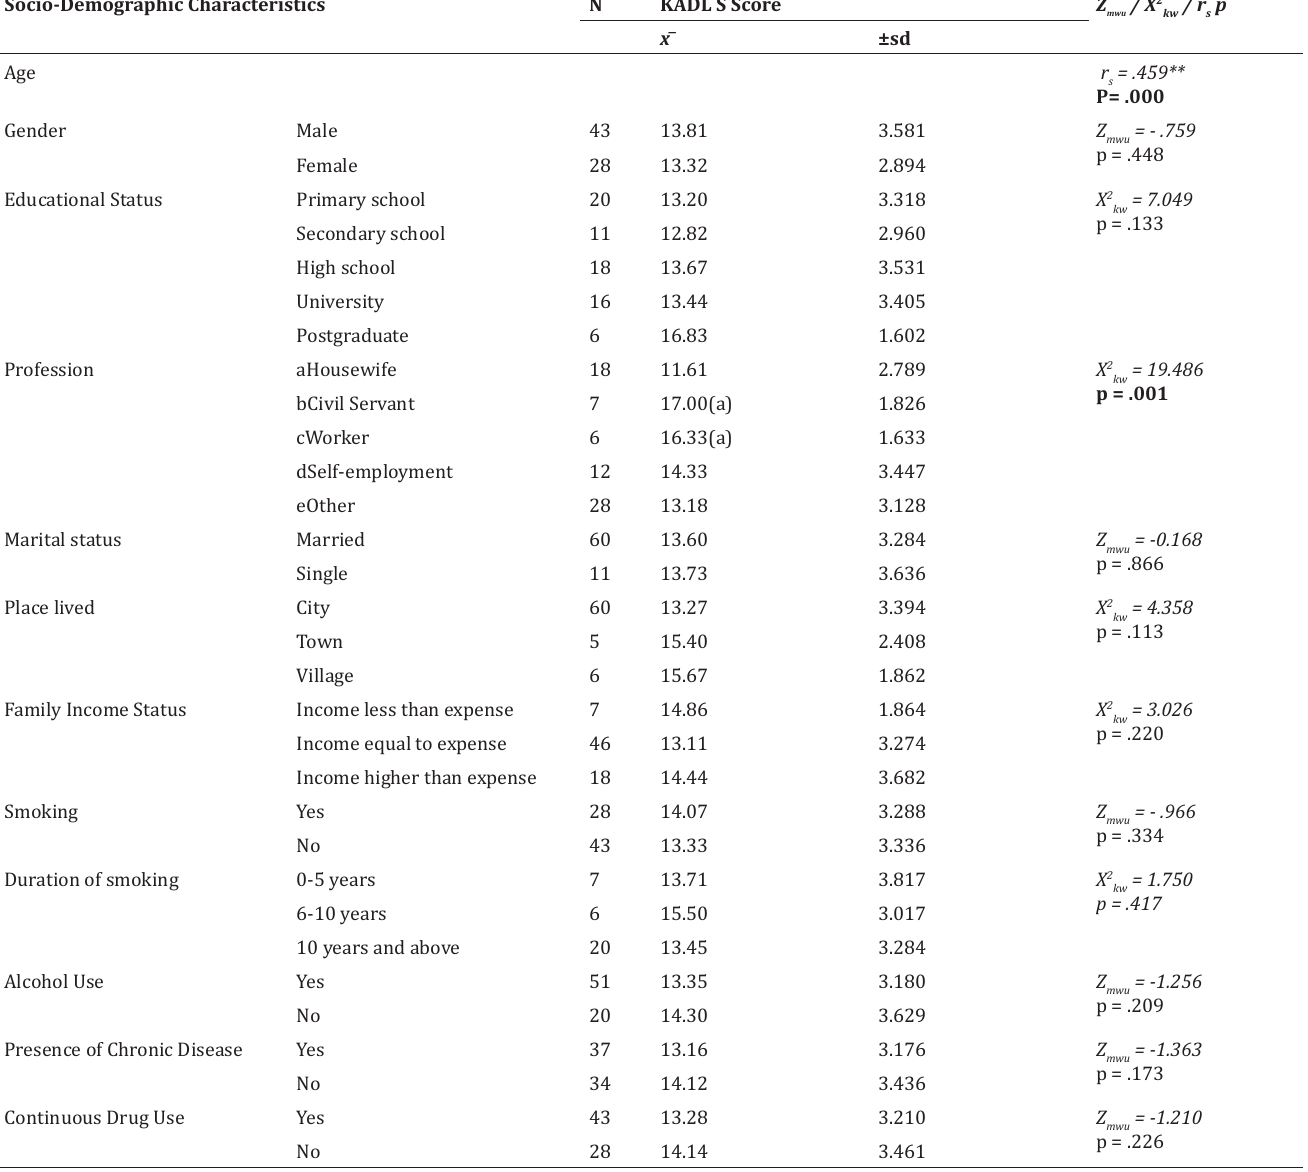
Comparison of KATZ Activities of Daily Living Scale Scores with the Patients' Socio-Demographic